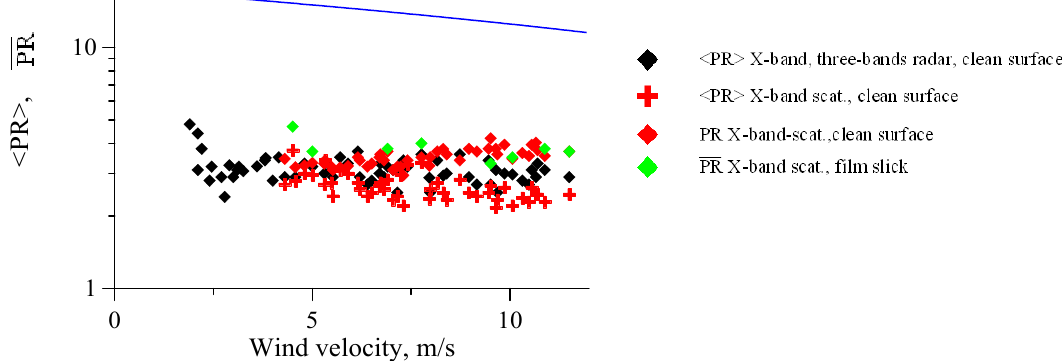
Figure 4. Mean PR vs. wind speed, upwind direction, X-band radar. Black symbols correspond to the three-band radar. Red rhombuses indicate the (cid:104) PR (cid:105) of the X-band scatterometer, red crosses indicate the PR of the X-band scatterometer, green rhombuses indicate the PR for slicks (the X-band scatterometer). The blue line corresponds to two-scale Bragg scattering theory. Incidence angles are 55–60 deg.